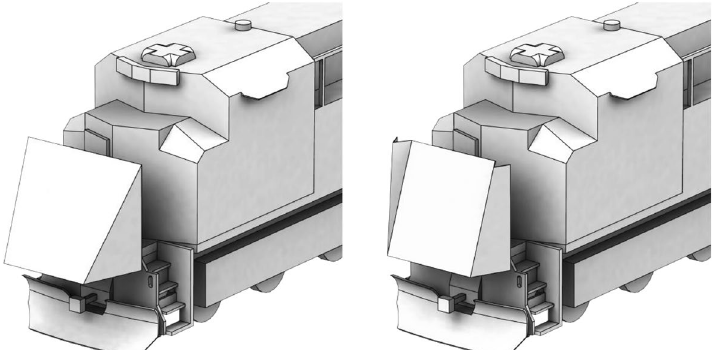
Fig. 7 Left Panel: Isometric rendering of the best performing geometry from the primary fairing shape family. The fairing is defined by the following design variable values: x 1 A Right Panel: Isometric rendering of the best performing secondary fairing shape. The fairing is defined by the following design variables: x 1 A